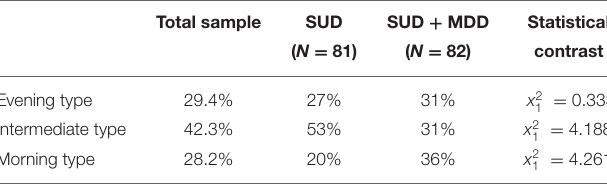
TABLE 4 | Results of the circadian typology for the total sample, SUD, and SUD + MDD patients. Total sample SUD SUD + MDD Statistical ( N = 81)